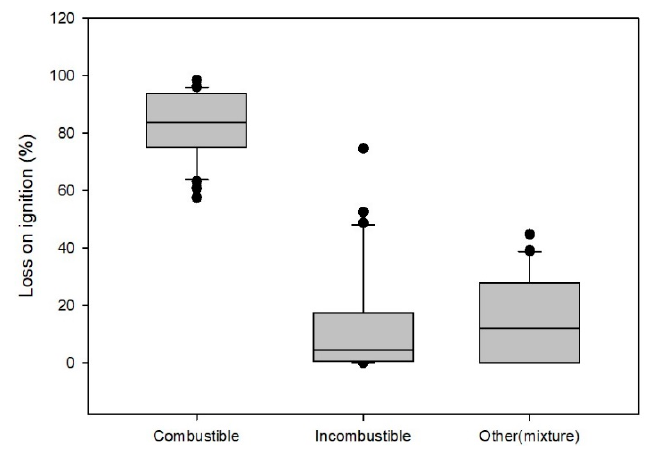
Figure 2. Loss on ignition of residues from SRF facilities.